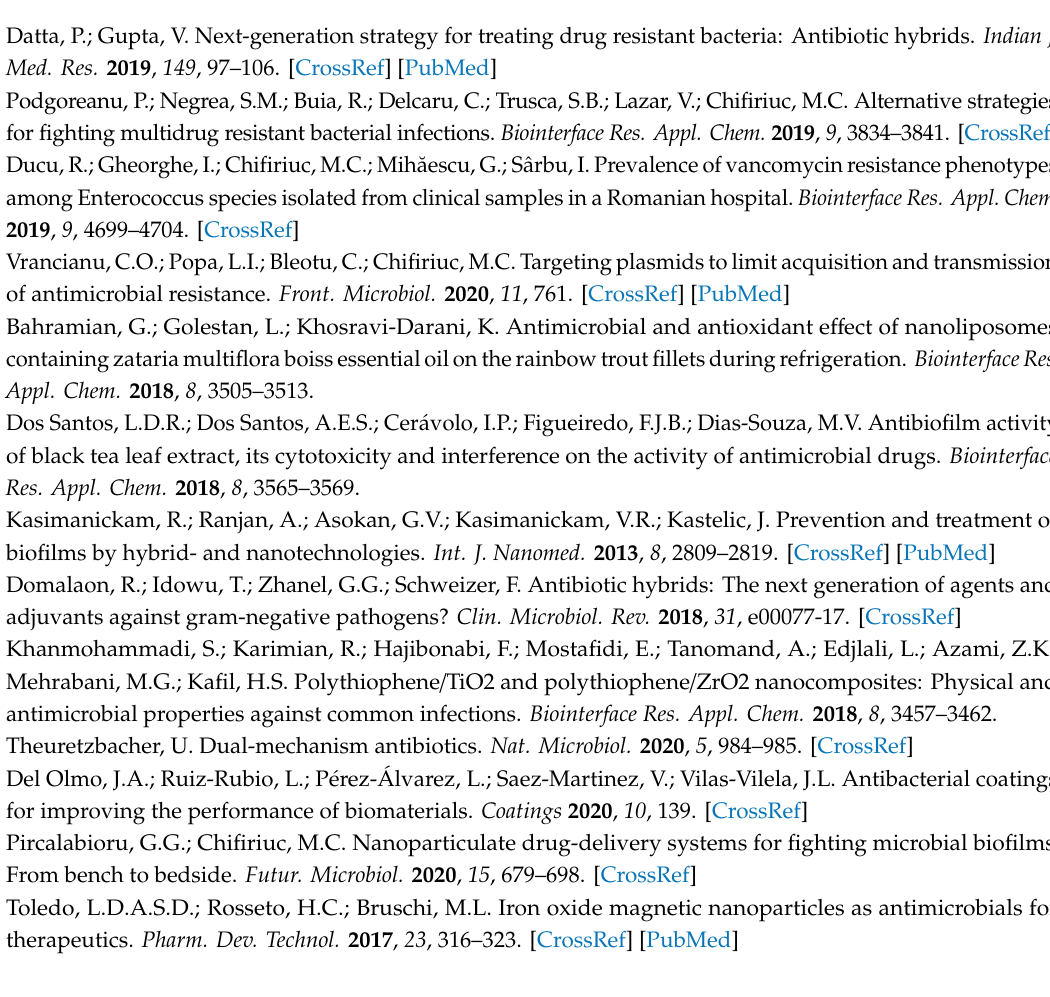
Figure S1: Supramolecular dimer of ( 1 ) in the solid-state, Figure S2: Crystal packing of ( 2 ) in the ab